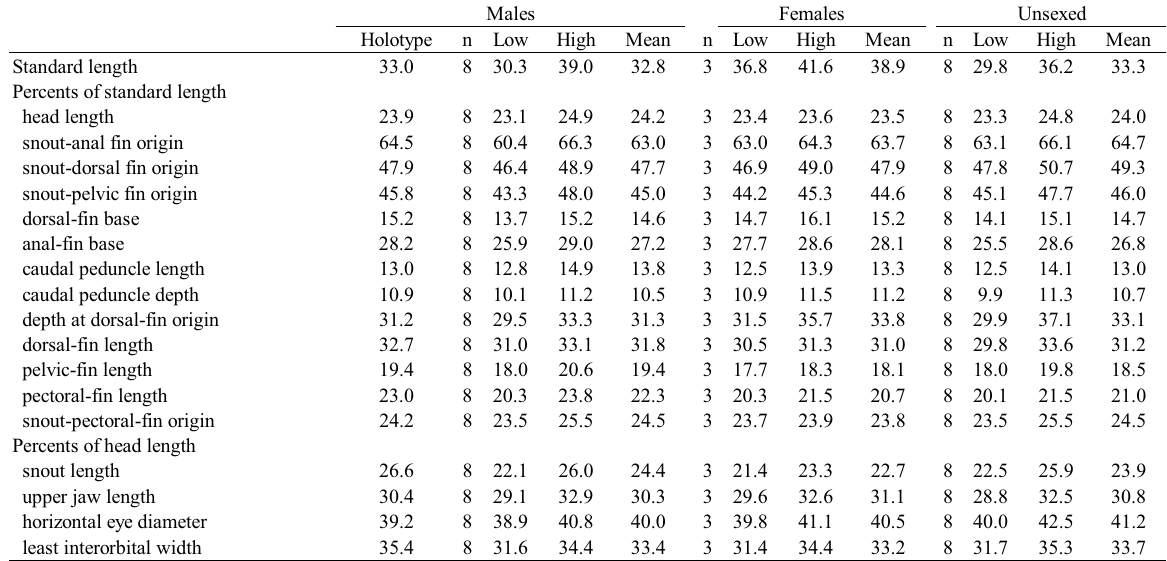
Table 4. Morphometrics of Odontostilbe parecis n. sp. (holotype INPA 24885, paratypes INPA 21424, and MCP